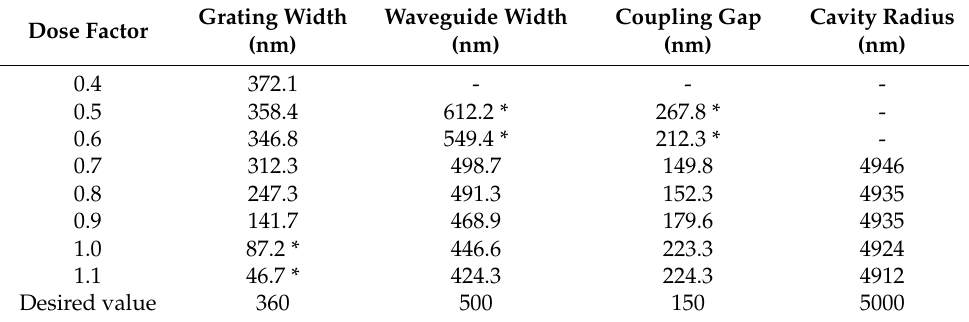
Table 4. Ion beam etching (IBE) results of di ff erent factors.